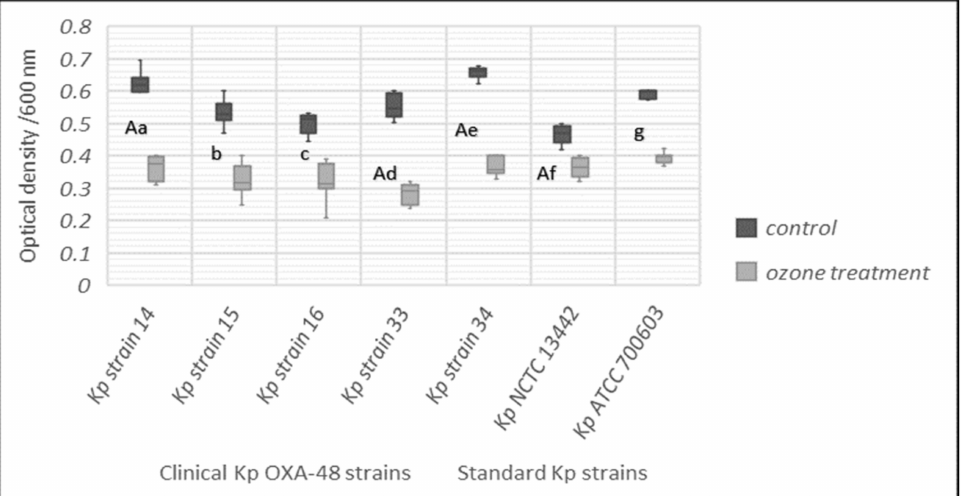
Figure 4. Biomass determination (CV staining) for control and treated K. pneumoniae strains (Kp) after treatment of 24 h biofilm with 25 ppm of ozone for 1 h. Results shown with median value (-) and minimum and maximum value. Lowercase letters, a–g, express the statistically significant difference between the treated and control group for the 7 tested strains (Mann–Whitney U test, p < 0.05). The capital letter A marks the statistically significant difference between strains Kp ATCC 700603, Kp strain 14, Kp strain 33, Kp strain 34 and Kp NCTC 13442, and vice versa (Kruskal–Wallis test, p <